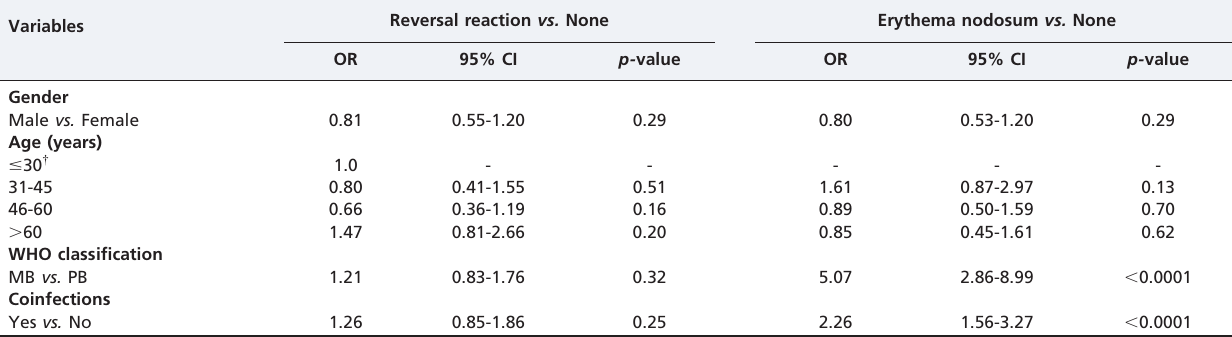
Table 3 - Multinomial logistic regression model of the risk factors for reactional episodes (reference = no reaction) by the gender, age, WHO classification, and presence of coinfections in the leprosy patients managed at the Leprosy Clinics of the Ribeira˜o Preto Clinical Hospital in the Medical School of Sa˜o Paulo University, calendar period 2000-2010. Odds ratio (OR), 95% confidence interval (95% CI) and p- value.